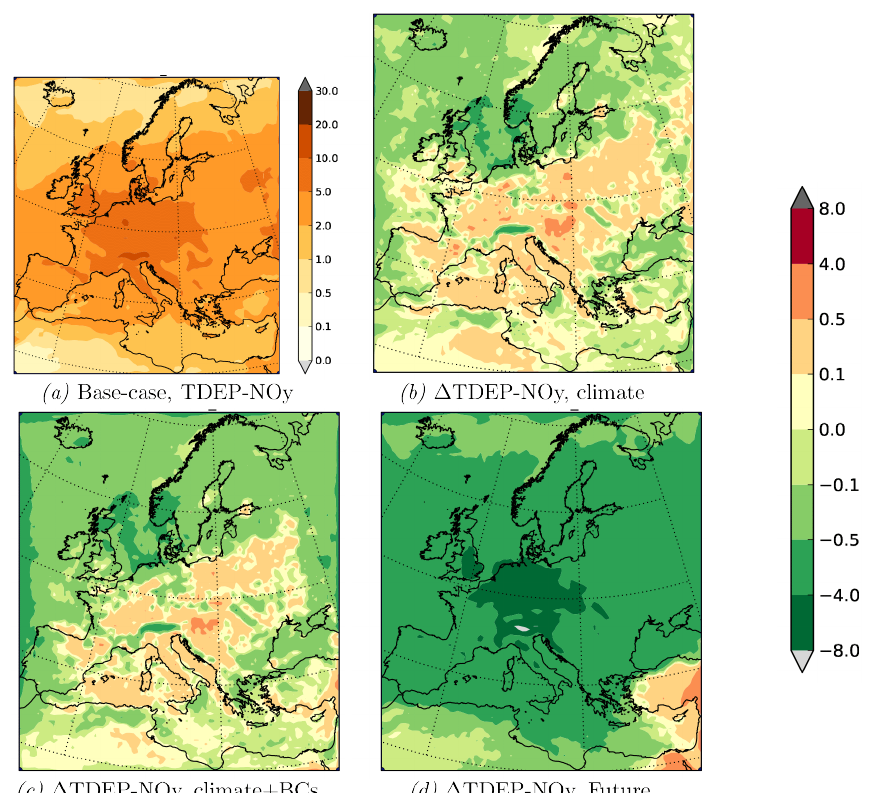
Figure 5. Results from the 3CTM ensemble (see text), for (a) base-case deposition of NO y (TDEP-NO y , innermost legend), and changes in TDEP-NO y (rightmost legend) resulting from (b) 2050s climate (E05-M50-BC2), (c) 2050s climate and boundary conditions (E05-M50- BC3), and (d) 2050s emissions, climate and boundary conditions (E50-M50-BC3). Unit: kg ( N ) ha − 1